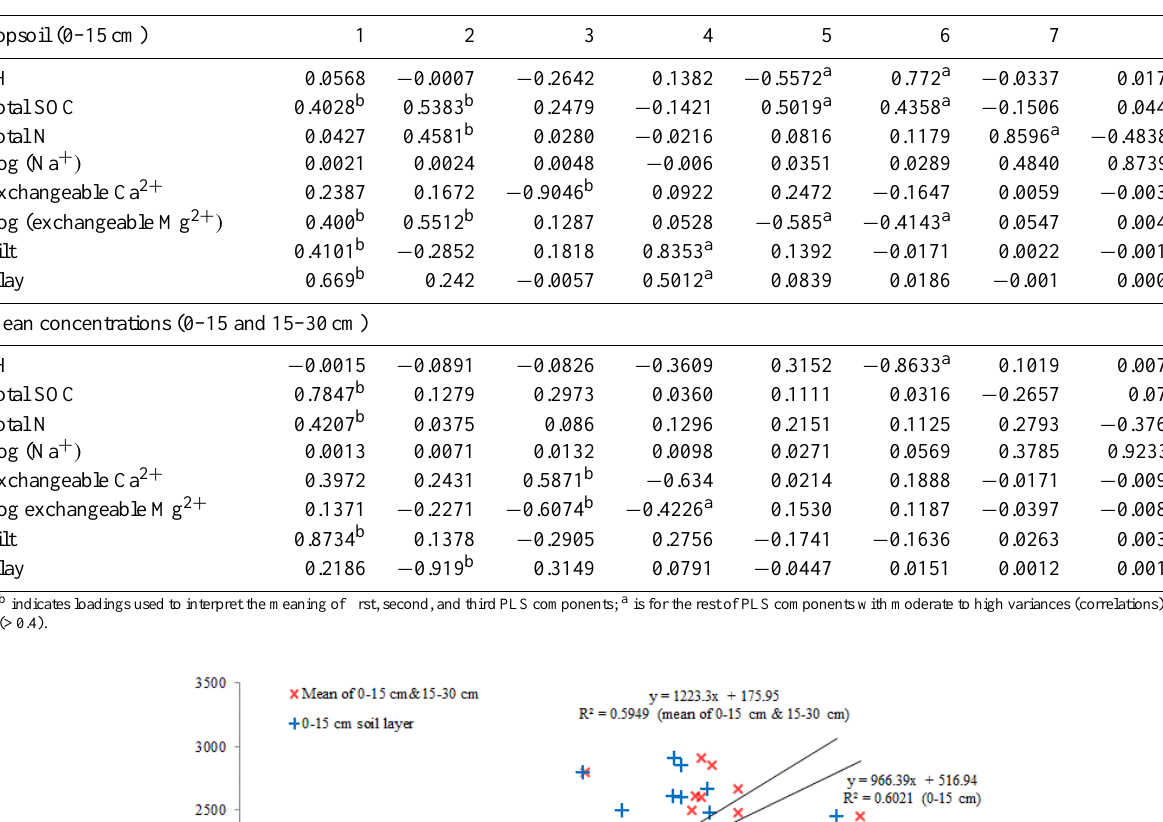
Table 4. Partial least-squares component loadings for soil parameters at 0–15cm and mean concentration from 0 to 15 and 15 to 30cm in a Ferralsol in Uganda.